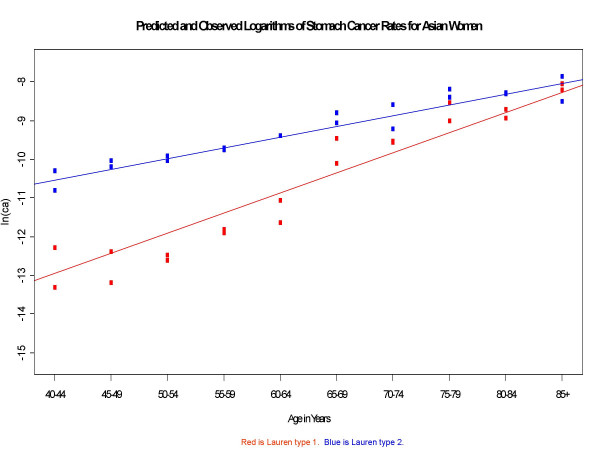
Plot of the natural logarithms of cancer rates, denoted as ln(ca), as a function of age in years for Asian women. Red references Lauren type 1 gastric cancer. Blue references Lauren type 2 gastric cancer. Lines represent predicted values. [see Additional file 1]